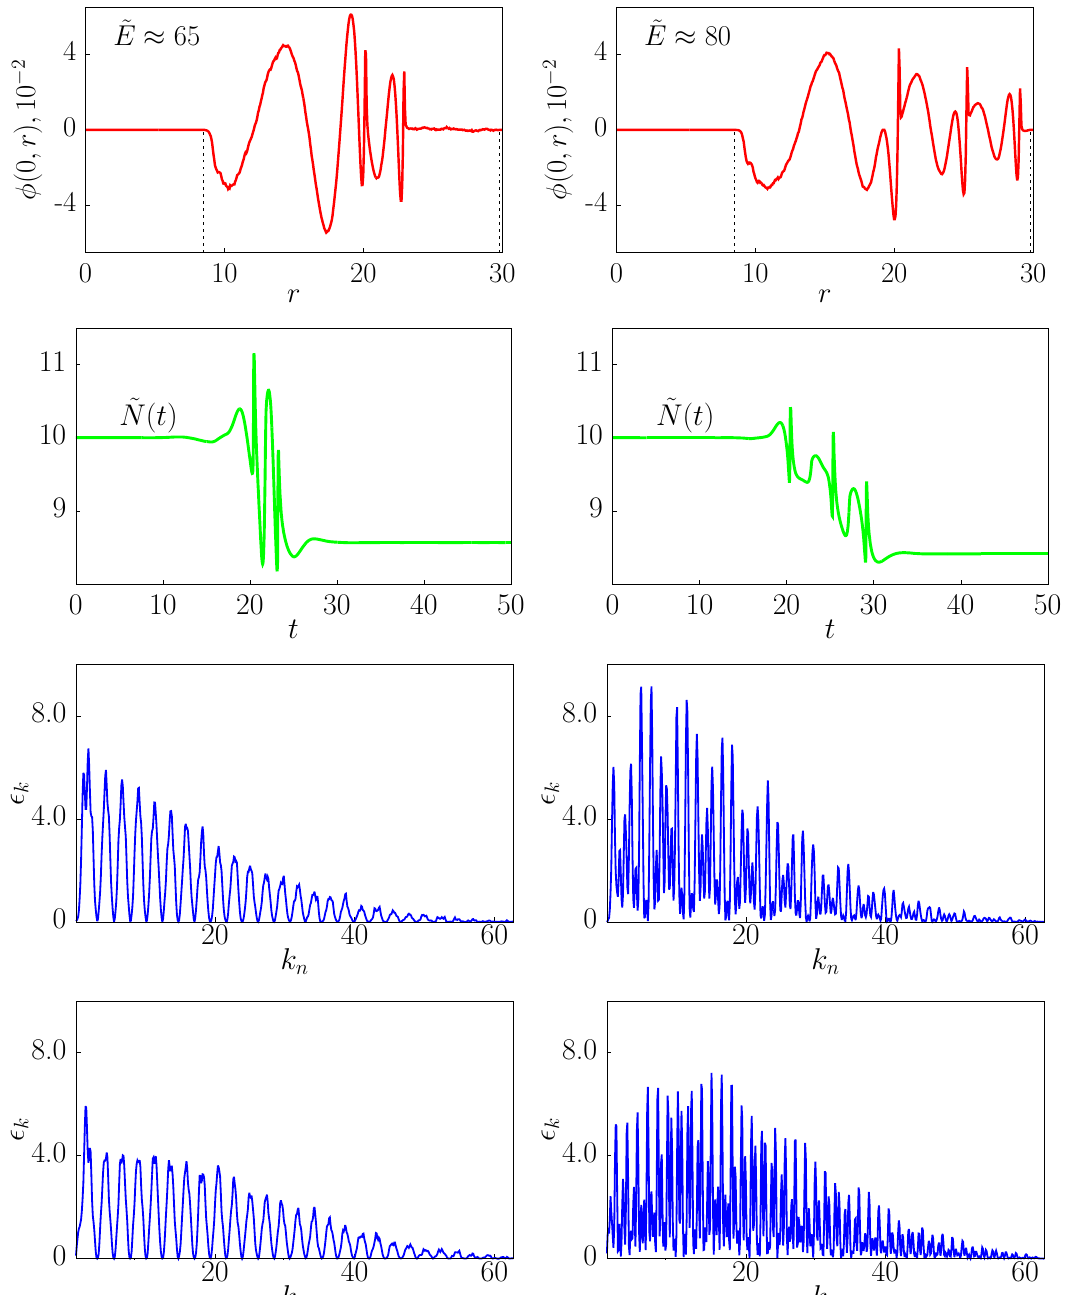
Figure 14 . From top to bottom: a) initial wave packet; b) evolution of the instantaneous particle number ~ N ( t ); c) distribution of energy over the modes (cid:15) k per wave number for the initial (cid:12)eld con(cid:12)guration; d) the same as in c) but for the (cid:12)nal (cid:12)eld con(cid:12)guration. Left and right panels correspond to the lower boundary solutions with ~ E (cid:25) 65 and 80, respectively.